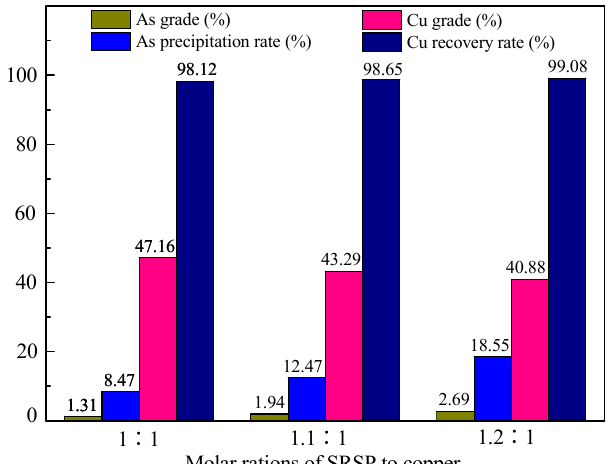
Figure 3. Effect of different molar ratios of SRSP to copper on copper selective recovery (pH value: 0.70, reaction time: 40 min).